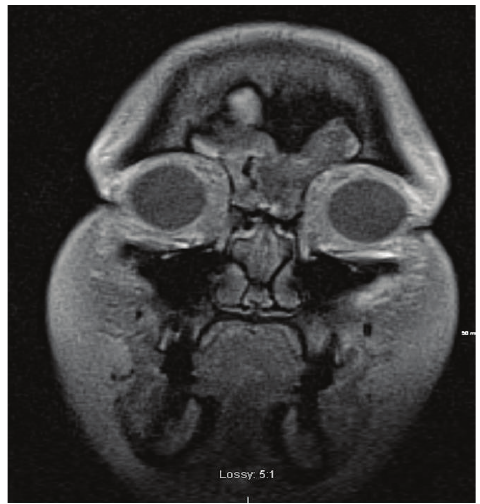
Figure 1: Axial CT scan showing the osseous tumor filling the frontal recess bilaterally.